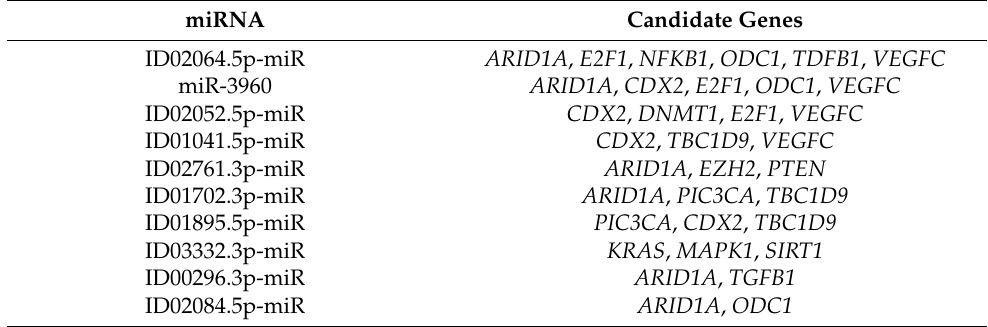
Table 4. The association of miRNA and alternative candidate genes for gastric